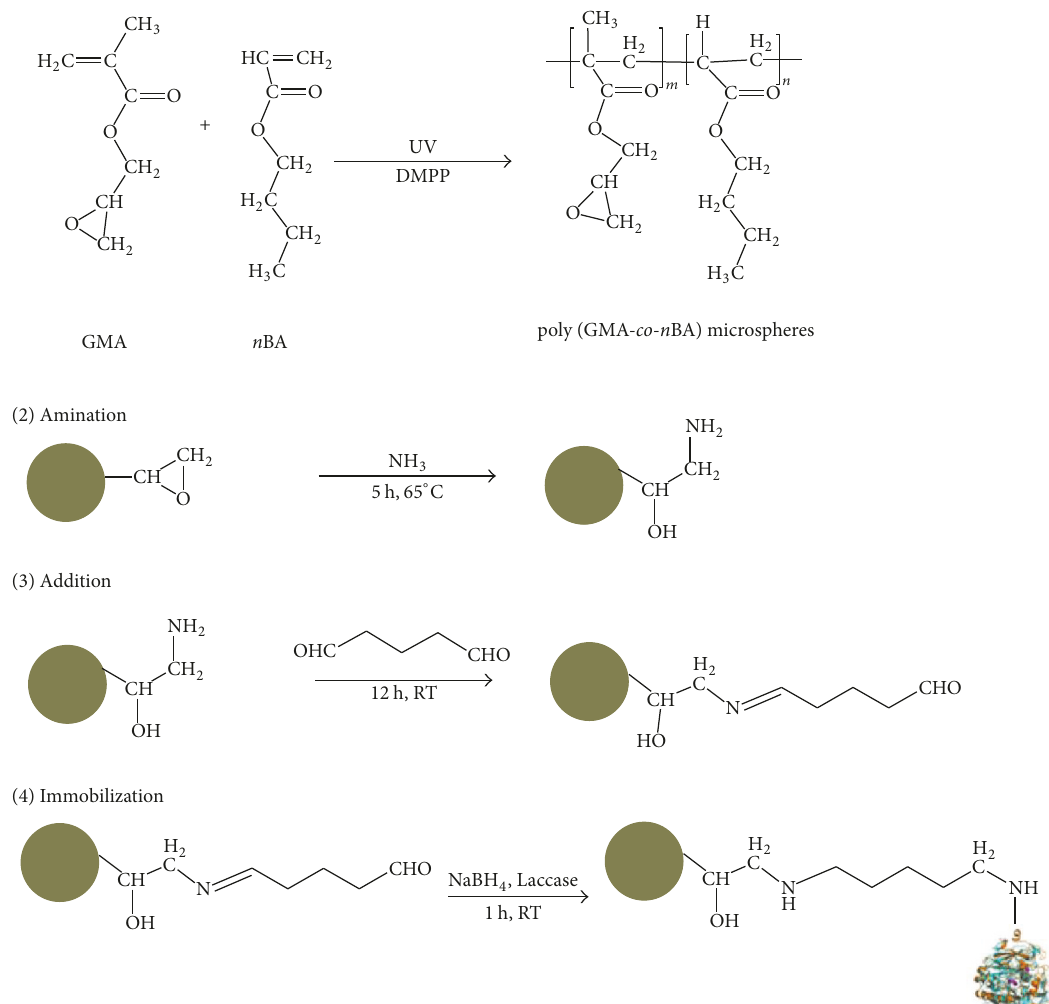
Figure 1: Proposed schematic reaction of poly(GMA- co - n BA) microspheres for laccase immobilization by covalent binding.